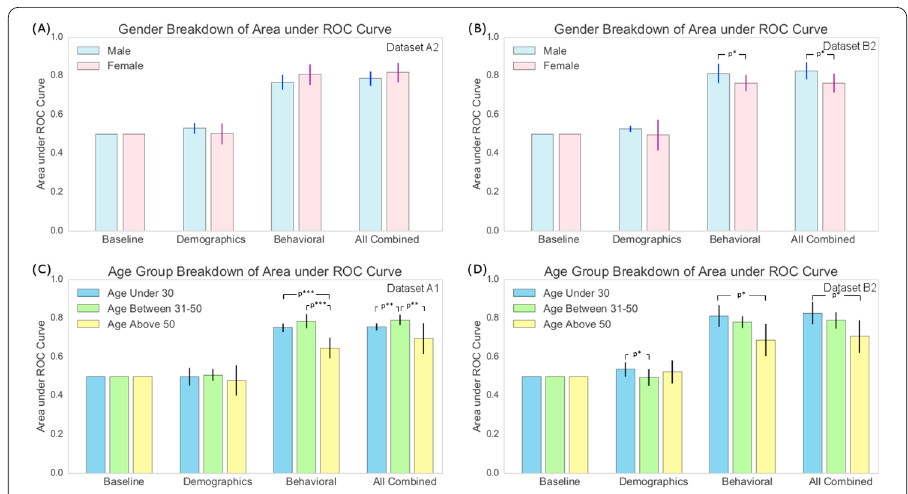
Figure 4 The breakdown of churn prediction performance based on gender and agegroups . The comparison is performed for the label inac-full . The length of the error bar corresponds to 1.0 standard deviation. p ∗ , p ∗ ∗ , and p ∗ ∗∗ denote the significance levels with p values smaller than 0.05, 0.01, and 0.001, respectively